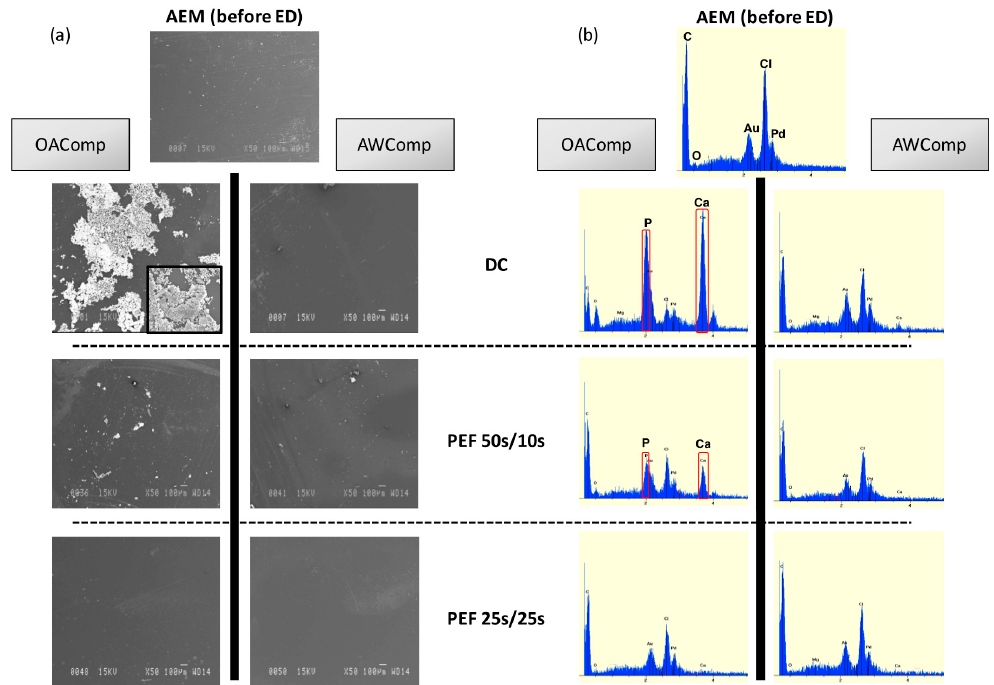
Figure 8. Scanning electron microscopy images with magnifications of 50× and 750× ( a ) and energy dispersive X-ray spectroscopy ( b ) of AEM sides for DC, PEF 50 s/10 s, and PEF 25 s/25 s current conditions compared to pristine membranes.